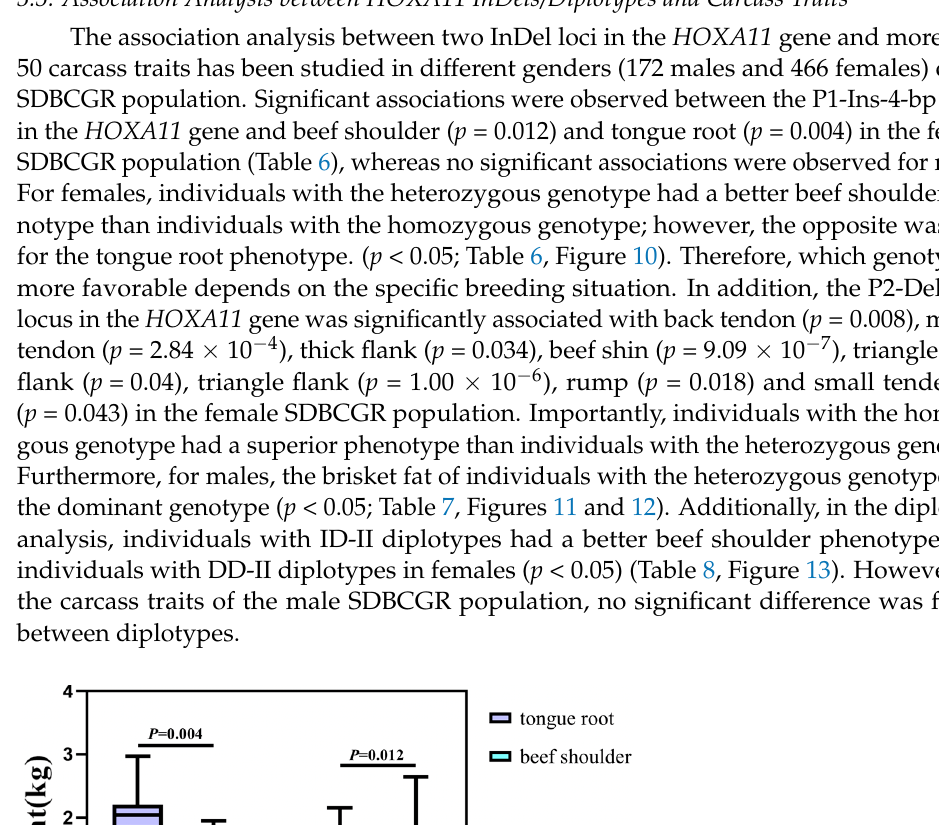
Table 6. Associations of the P1-Ins-4-bp InDel with carcass traits in the female SDBCGR popula- tion.